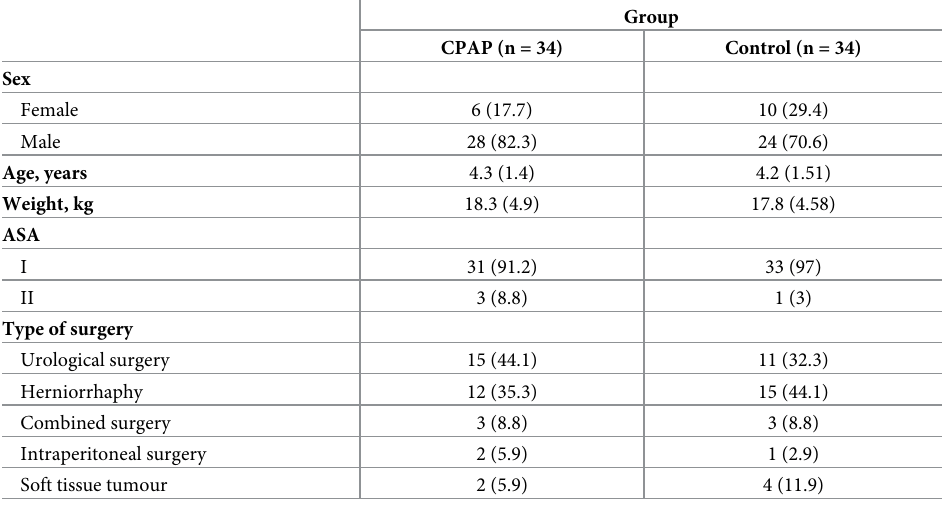
Table 1. Characteristics of children with CPAP-ventilation and passive CPAP-oxygenation (10 cmH 2 O) or no positive pressure (0 cmH 2 O) during anaesthesia induction for elective surgery.